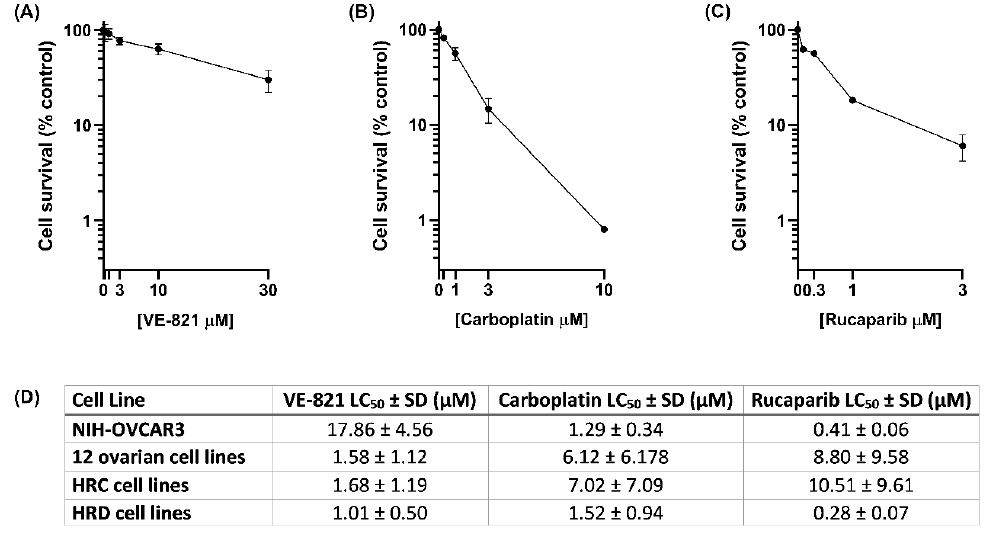
Figure 2. Sensitivity of NIH-OVCAR3 cells to VE-821, carboplatin and rucaparib. NIH-OVCAR3 cells were exposed to ( A ) VE-821 for 48 h, ( B ) carboplatin for 24 h or ( C ) rucaparib for 24 h. Media was replaced with drug free media for 21 days to allow colony formation. Data are the mean and standard deviation of at least three independent experiments. ( D ) Sensitivity of an additional 12 ovarian cancer cell lines to the three drugs was calculated in the same way and LC 50 values were calculated. Sensitivity of NIH-OVCAR3 cells in comparison to the mean of 12 other ovarian cancer cell lines, and the cell lines grouped by their HRR status into HRR competent (HRC, 3 cell lines) or HRR defective (HRD, 2 cell lines). Data are pooled from 3 independent experiments per cell line. Western blot confirming the loss of TP53 function in NIH-OVCAR3 cells can be found at Figure S3.